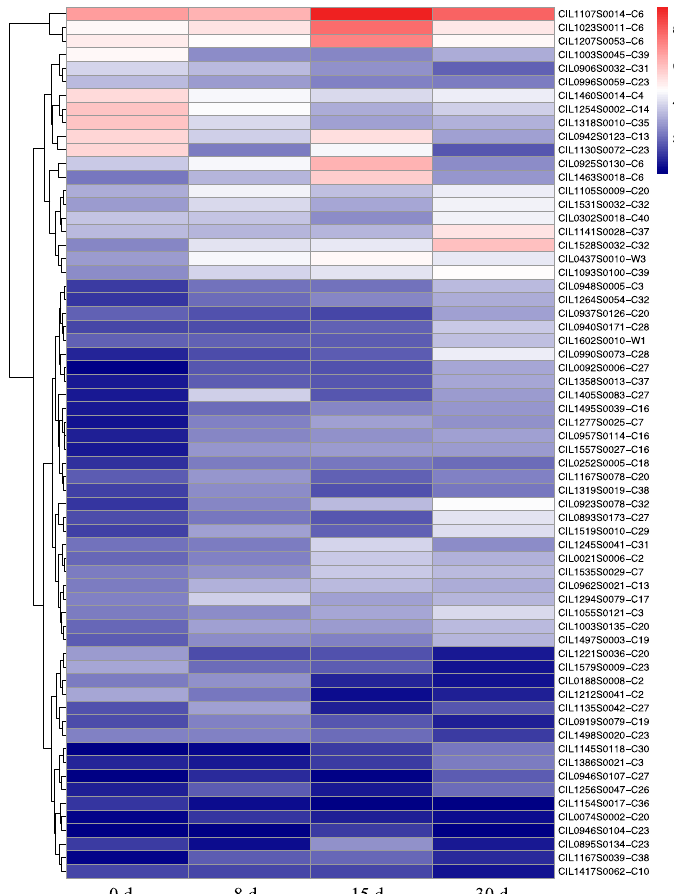
Figure 6. A heatmap of the expression levels of 64 differentially expressed R2R3-MYB genes after grafting in pecan. The heatmap denoting the log 2 (FPKM + 1) of target genes from RNA-seq data was derived using the pheatmap package with hierarchical clustering in R language. The color scale indicates gene expression levels, with purple representing low expression levels and red representing high levels.